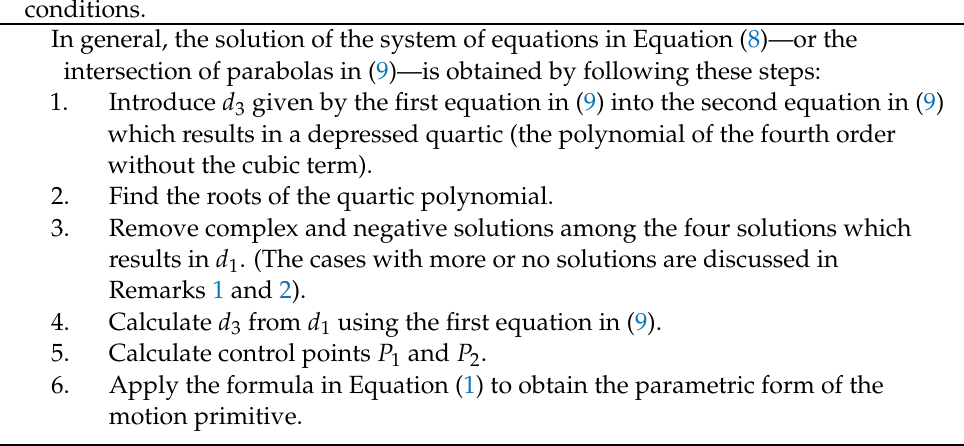
Algorithm 1: The algorithm for calculation of motion primitives from boundary